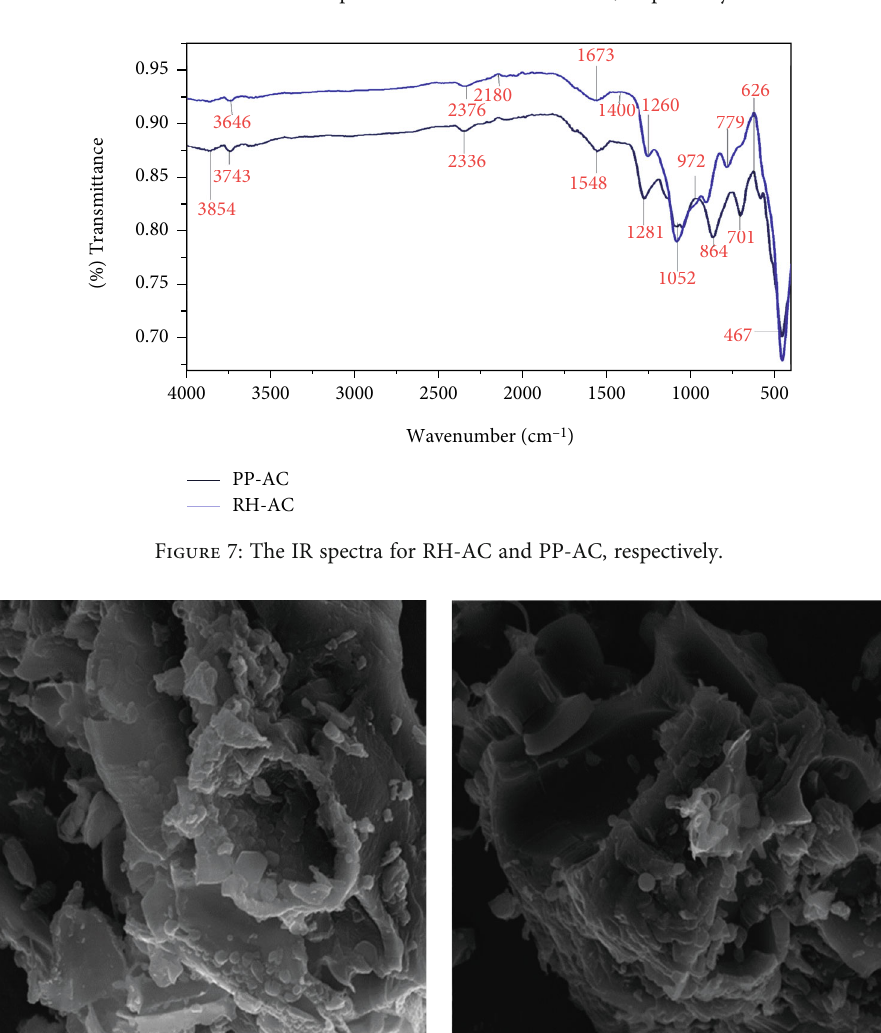
Figure 6: The XRD spectra for RH-AC and PP-AC, respectively.